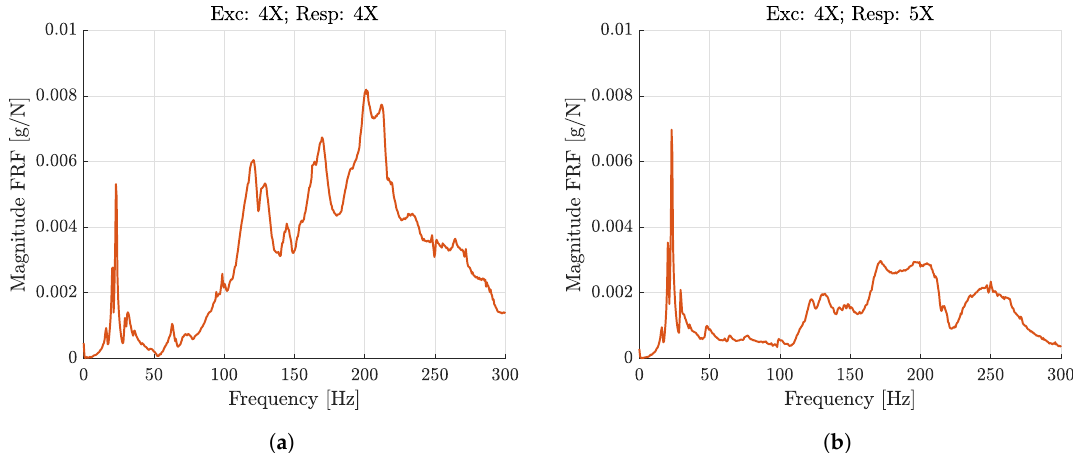
Figure 9. FRFs of Y-rail (Figure 7): ( a ) direct (excitation 4X, response 4X), ( b ) cross (excitation 4X, response 5X).